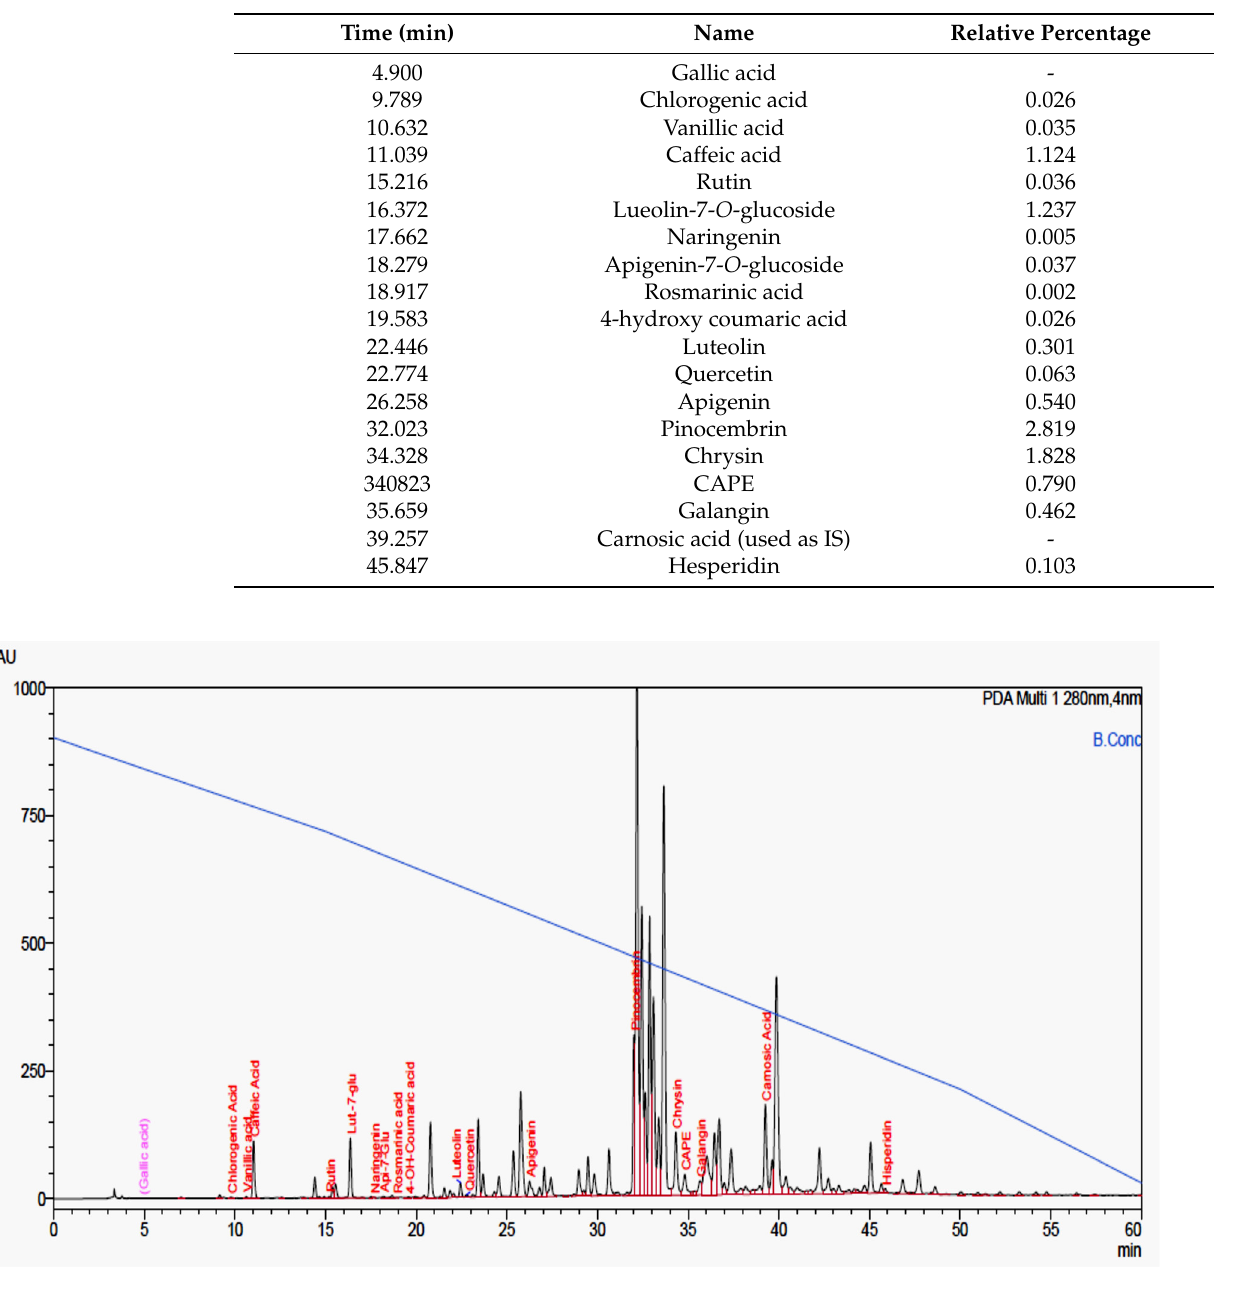
Table 3. LC-MS-MS analysis of pesticide in the propolis. Pesticide